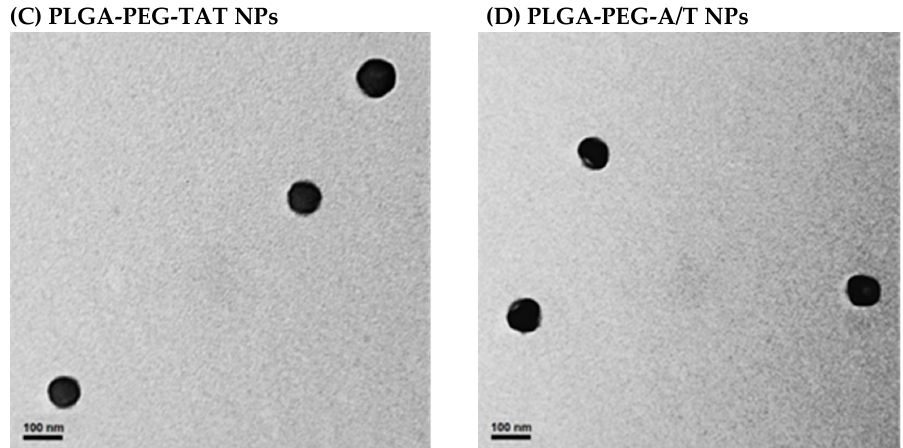
Figure 1. TEM photographs of ( A ) PLGA-PEG NPs, ( B ) PLGA-PEG-AG NPs, ( C ) PLGA-PEG-TAT NPs and ( D ) PLGA-PEG-A/T NPs (scale bar: 100 nm).